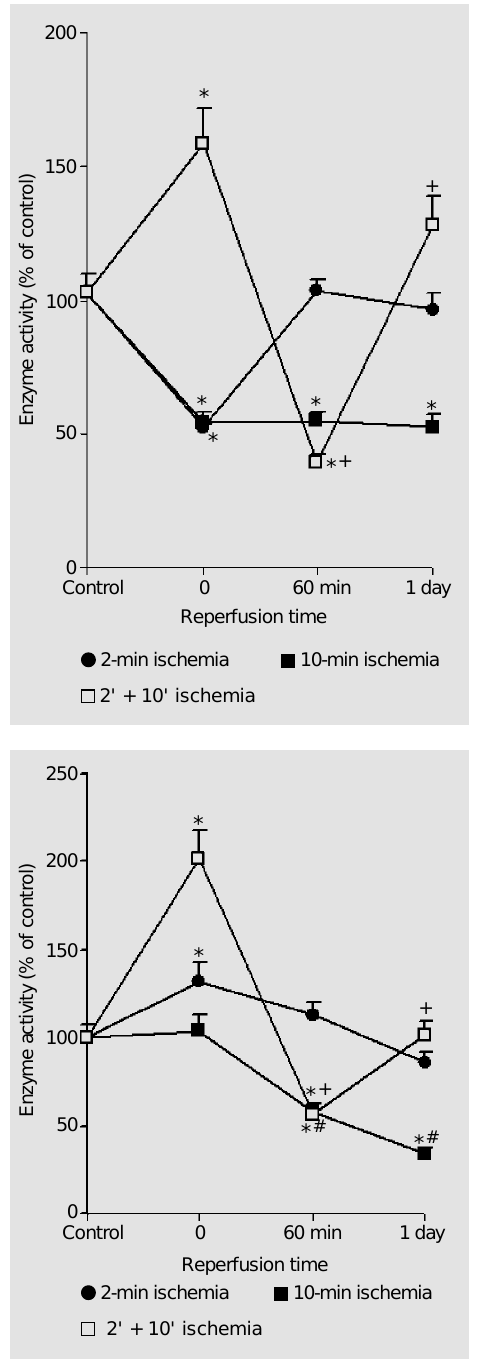
Figure 3 - Activity of platelet 5'- nucleotidase (AMPase activity) after brain ischemia (2 and 10 min) and ischemic precondition- ing (2' + 10') followed by reper- fusion. Results are expressed as percentage of control activity. Data are reported as means ± SEM for 6 to 8 different platelet preparations assayed in